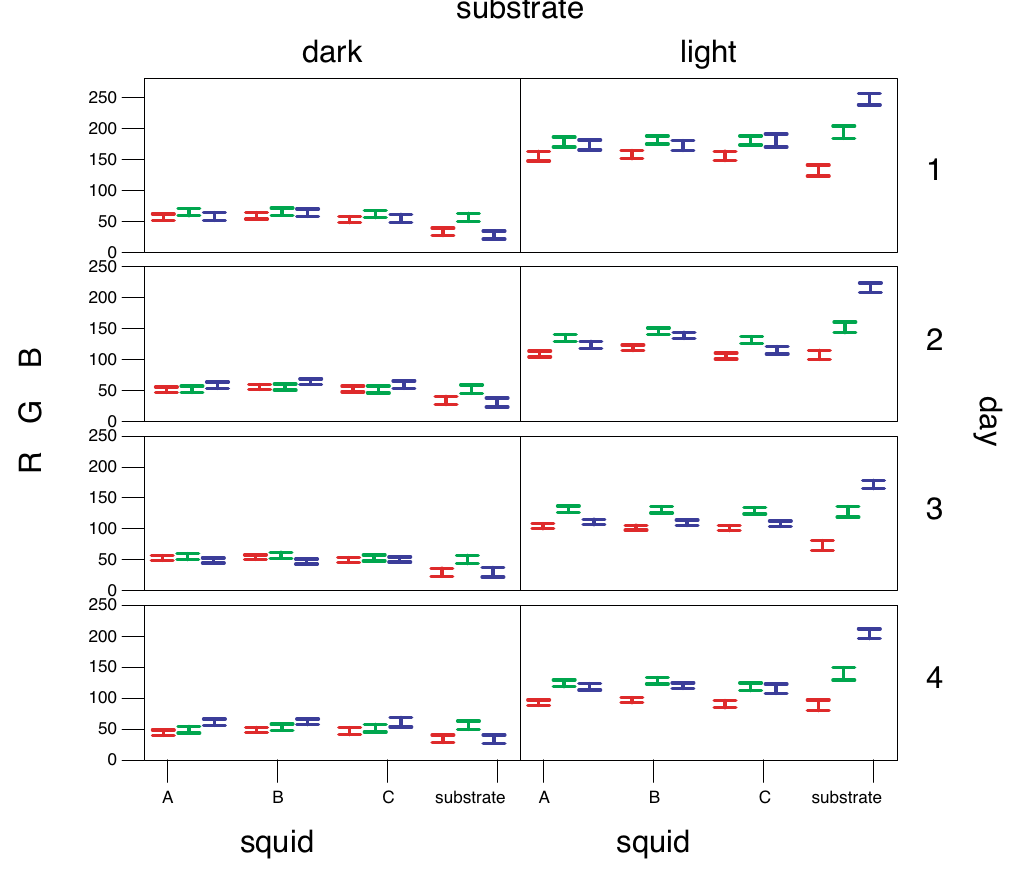
Figure 4. Average head RGB values per day (1–4) per white-squid ( A–C ) and the substrate on dark and light substrate areas. Error-bars represent a 95% confidence interval for the